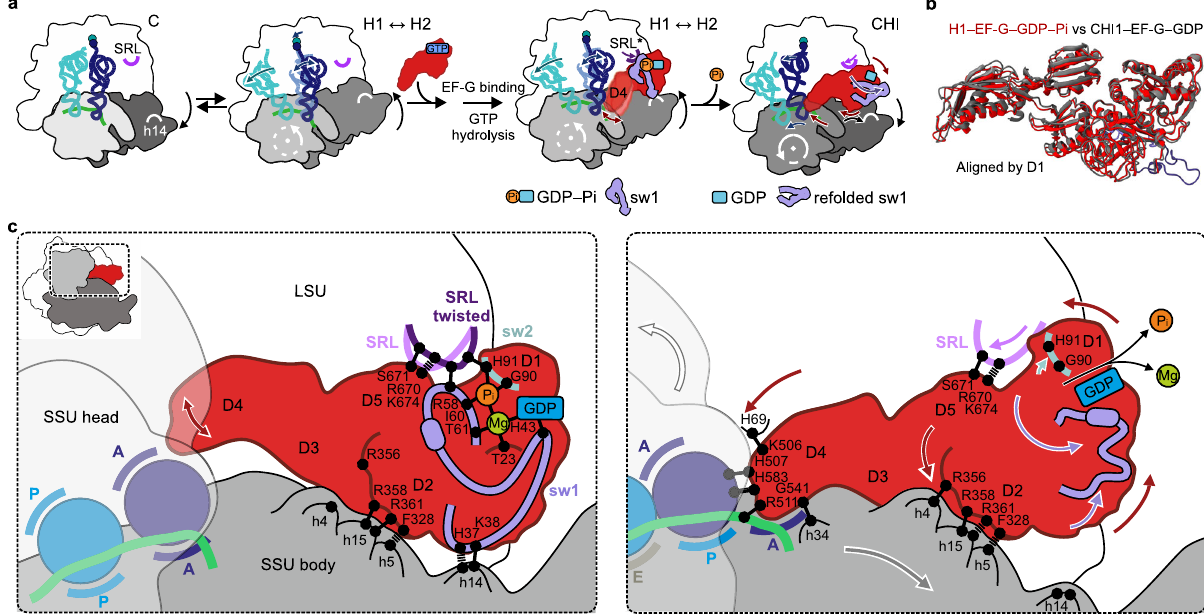
Fig. 5 Coupling of GTP hydrolysis by EF-G to ribosome – tRNA movements. a Overview of early translocation events as seen by cryo-EM. b Superposition of EF-G in GDP – Pi vs. GDP state. Note the similar overall conformation. c A GTPase “ loaded spring ” mechanism driving translocation. Left: binding of EF- G – GDP – Pi stabilizes a unique twist of the SRL via sw1 and sw2 of EF-G. The compact sw1 bridges between the SRL and h14 of 16S rRNA and stabilizes the SSU in the rotated state, whereas EF-G D2 forms numerous contacts with the SSU body domain (h5, h15). Fluctuations of EF-G D4 reach deep into the decoding site of the SSU (red arrow). Right: Pi release results in refolding of sw1 (purple arrows), which loosens the interactions that held the SSU in the rotated state and initiates a cascade of coupled structural changes: (i) the SSU body rotates backwards (gray arrow). (ii) The SRL relaxes back into its ground state (magenta arrow). (iii) EF-G rotates together with the SRL and rolls on the SSU shoulder (red arrows), forming new interactions with h4 that stabilize the non-rotated conformation of the SSU body domain. (iv) EF-G D4 binds into the decoding center of the SSU, stabilizing the SSU head domain in the swiveled state (white arrow) and promotes the movement of the tRNA – mRNA complex relative to the SSU into the chimeric tRNA